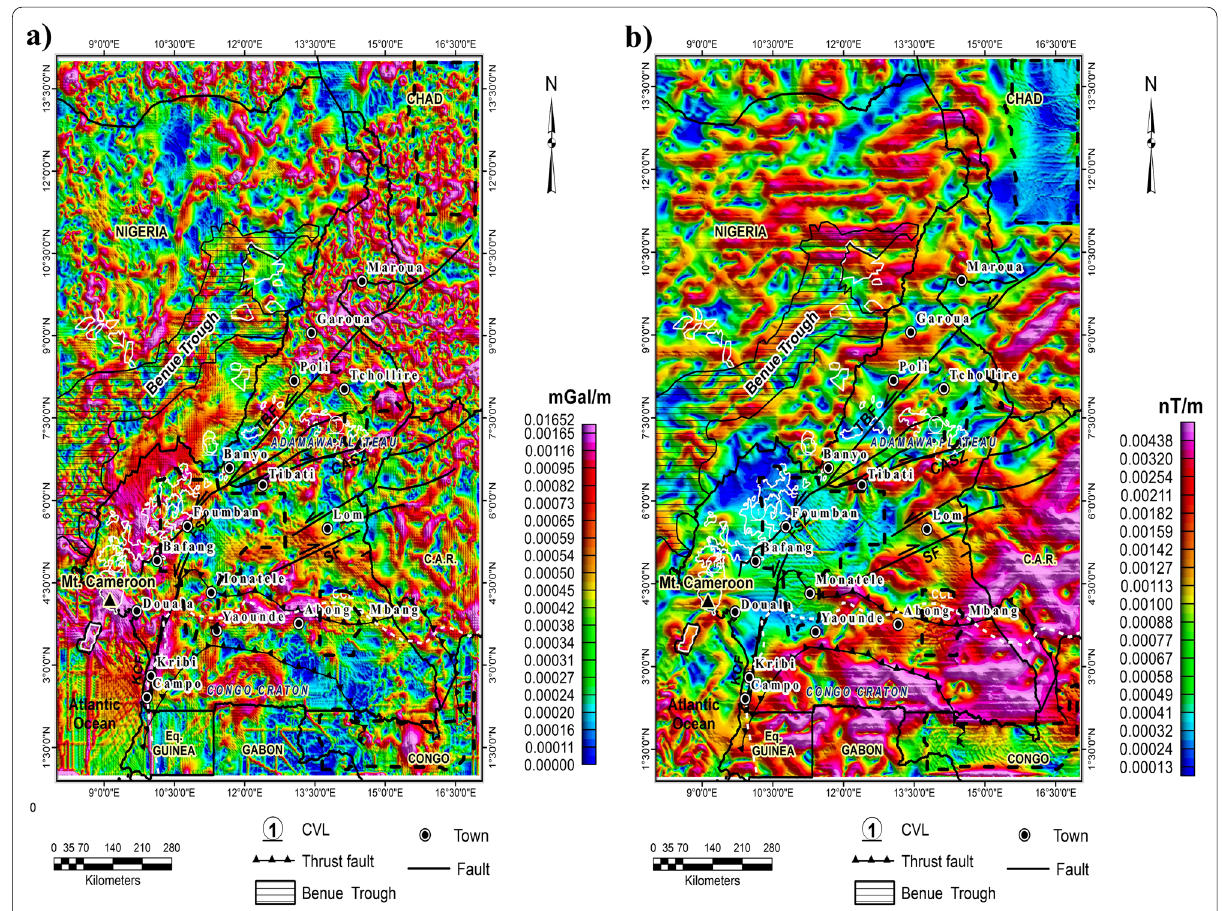
Fig. 5 Horizontal gradient map of: a Bouguer anomalies and b